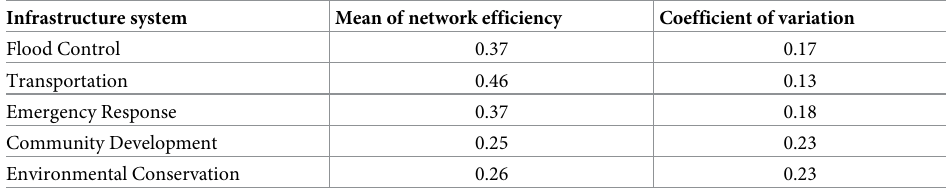
Table 4. Network efficiency under intra-layer link perturbation.